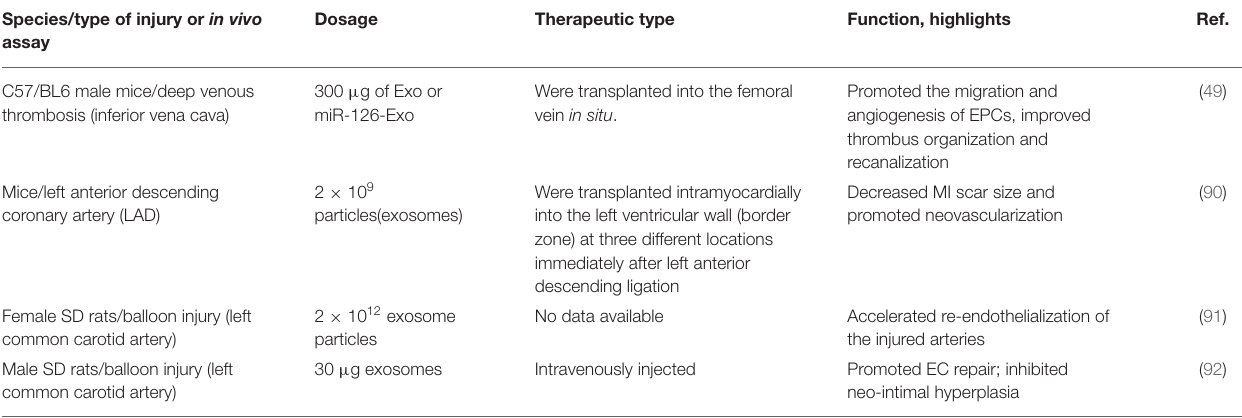
TABLE 3 | Therapy by exosomes/microvesicles for cardiovascular repair in animal in vivo models. Species/type of injury or in vivo Dosage Therapeutic type Function, highlights assay